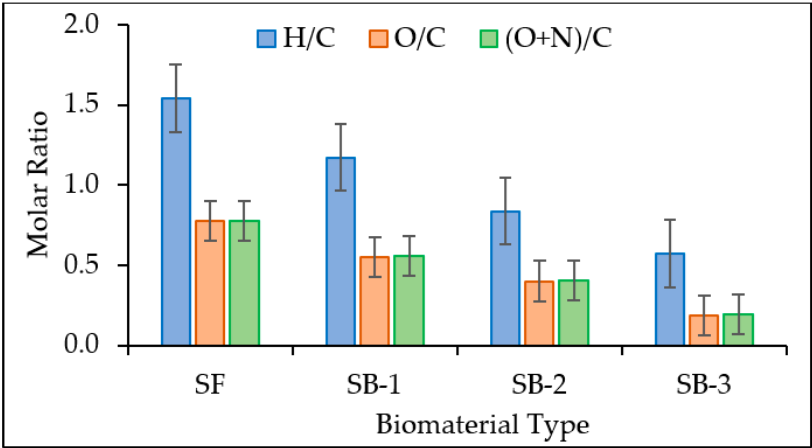
Figure 4. H/C, O/C, and (N + O)/C molar ratios of sesame feedstock (FS) and corresponding biochar types: parabolic dish collector (SB-1 and SB-2) and conventional method pyrolyzed at 300 °C.